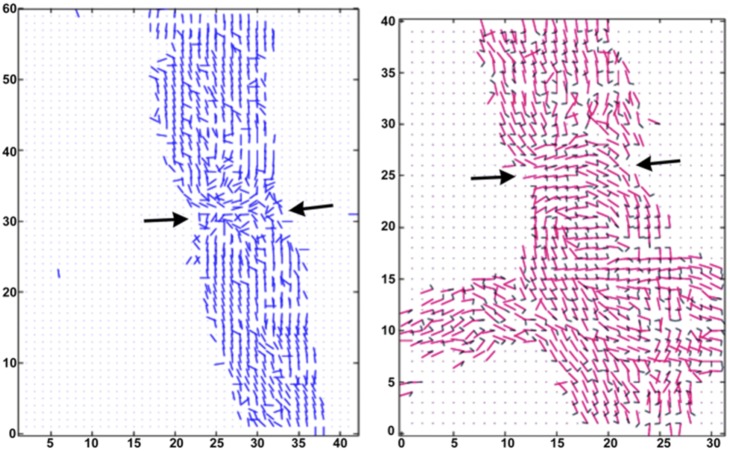
Orientation of patterns reveals changing in wrapping of myelin around axon.Mapping of the principal orientations of lamellar membranes in the region of a node of Ranvier (arrows) for a single myelinated nerve (left) and a pair overlapping fibers (right). To determine the overall orientation of the membrane planes on the nerve fiber, at each position we drew a line parallel to the plane of the membranes and perpendicular to the membrane stacking. The vast majority of reflections in the internode corresponds to membranes oriented parallel to the surface of the fiber. Neighboring the node of Ranvier, however, the lamellar stacks curl around and become more perpendicular to the axis of the nerve fiber (arrows). For clarity, orientation of less intense lamellar scattering is not shown for the single fiber (left panel). On the right, the orientations of the two most intense sets of lamellar reflections are shown by long red and short blue lines, respectively. Detailed analysis in this paper focuses on the image to the right.